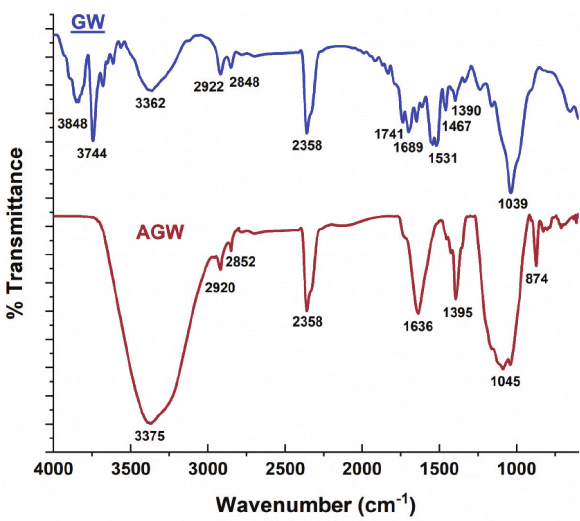
Fig. 1 – Fourier transform infrared (FTIR) spectrum of GW and AGW